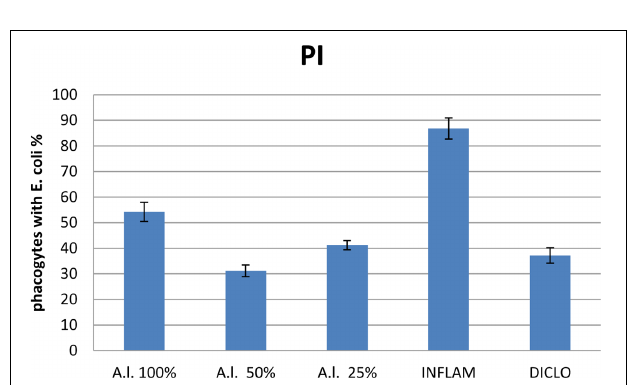
FIGURE 3 | Polymorphonuclear leukocytes (PMN). A.l. 100% – the animals received 5 mL/kg BW A. laxmannii ethanol extract 100% (100 mg dw/mL), A.l. 50% – the animals received 5 mL/kg BW A. laxmannii ethanol extract 50% (50 mg dw/mL), A.l. 25% – the animals received 5 mL/kg BW A. laxmannii ethanol extract 25% (25 mg dw/mL), Inflam – Inflammation was induced by i.m. injection of turpentine oil (6 mL/kg BW), Diclo – the animals received 20 mg/kg BW diclofenac ( p < 0.001).